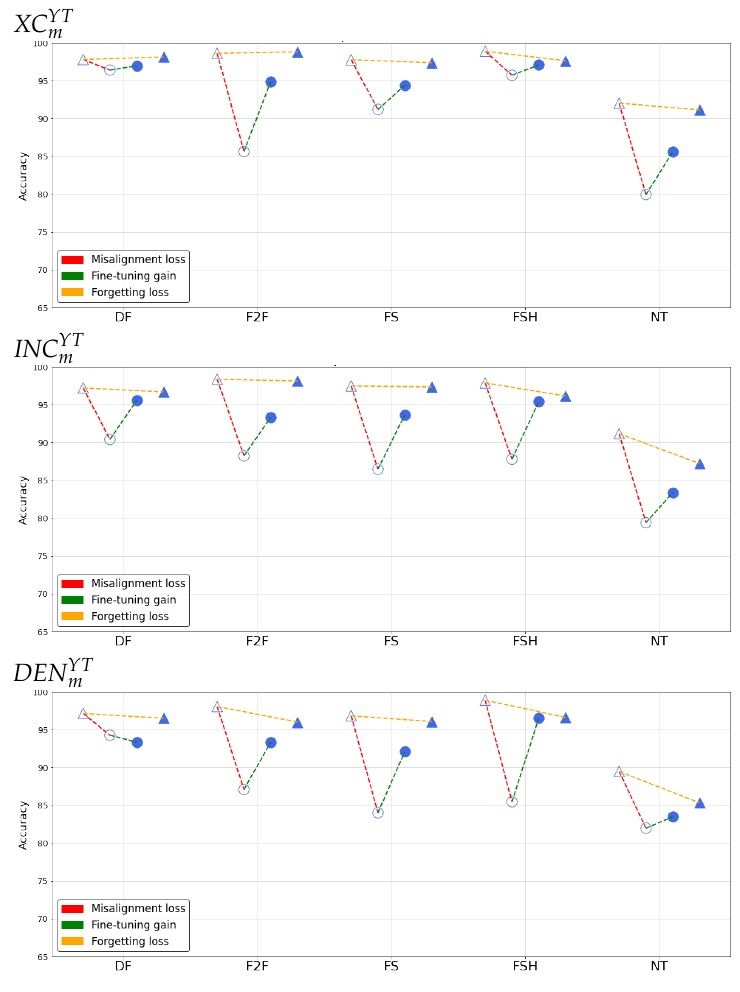
Figure 5. Accuracy results in the post-social results on YT